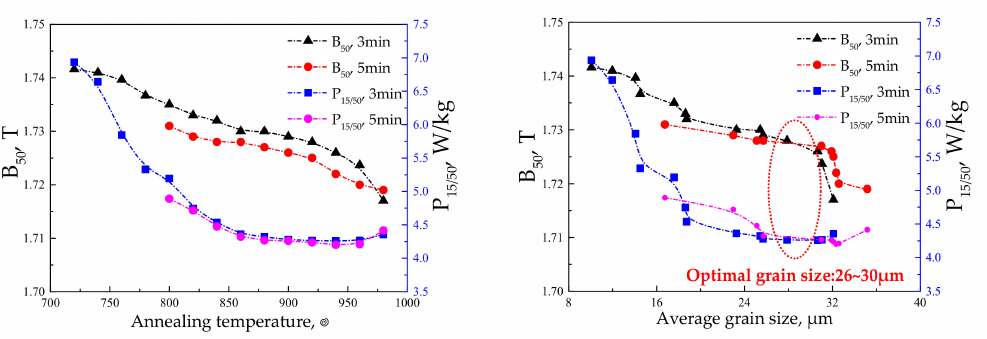
Figure 4. Trend of magnetic properties of Fe-0.65%Si non-oriented electrical steel with annealing temperature and grain